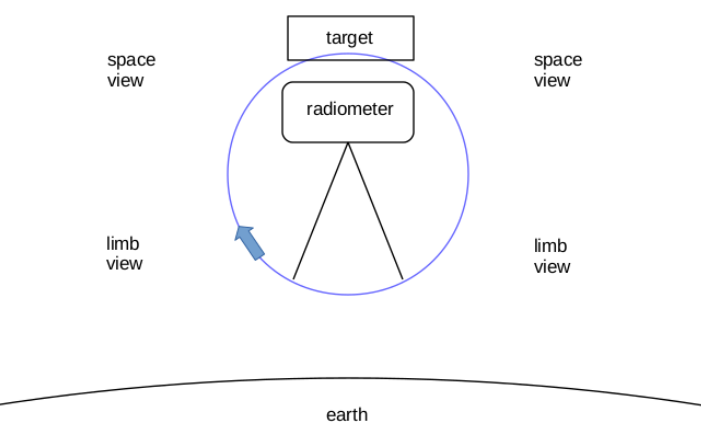
Figure 1. Radiometer/antenna/target scanning configuration.